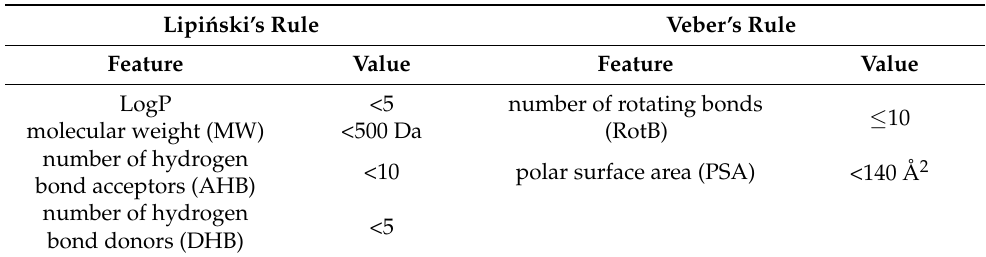
Table 1. Conditions included in Lipi´nski’s rule and Veber’s rule characterizing substances that are good candidates for